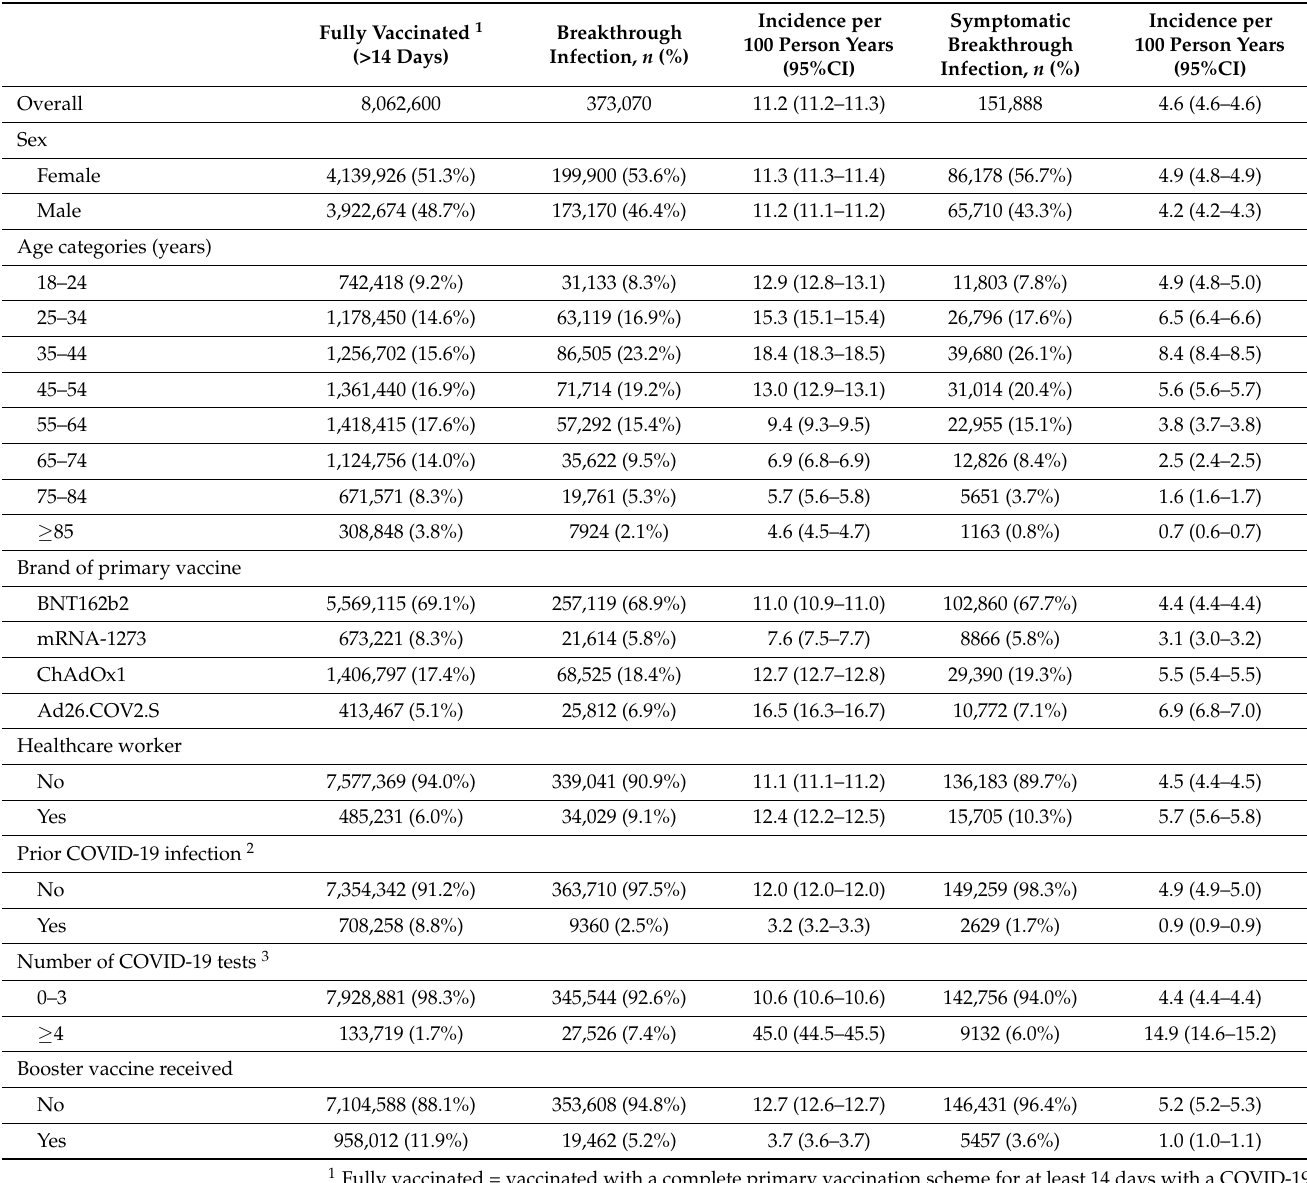
Table 1. Demographic and clinical characteristics of adult individuals who had been fully vaccinated and those with a breakthrough infection after full vaccination, as of 5 December